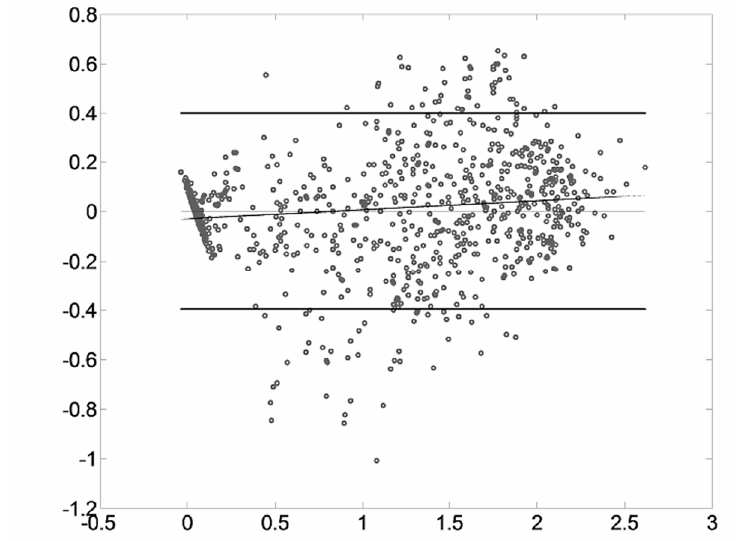
Figure 6. Bland-Altman Results for the rectus femoris muscle.